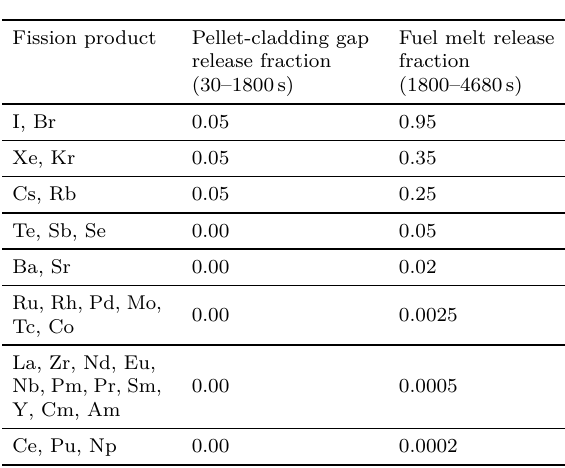
Table 2. Fraction of the fission products released during an accident [4].